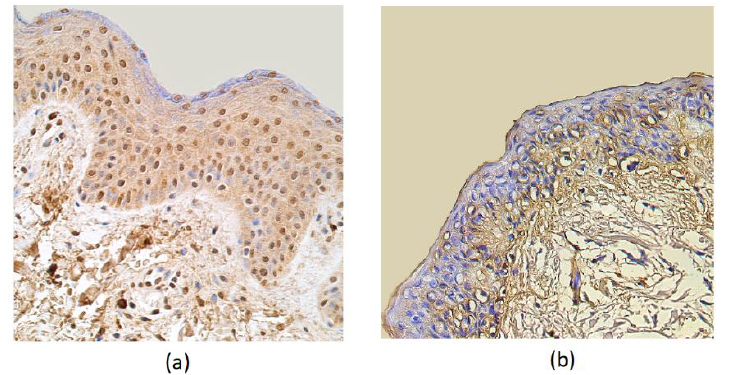
Figure 3. Immunohistochemical micrographs in rosacea-affected tissues and in control samples. ( a ) Note moderate HBD-4-containing epitheliocytes and in the subepithelial connective tissue of a 32-year-old rosacea-affected male. HBD-4 IMH, X 250; ( b ) only a few HBD-4-positive structures were displayed in the epithelium and no positive-stained structures in the connective tissue cells of 60-year-old control subject. HBD-4 IMH, X 200.